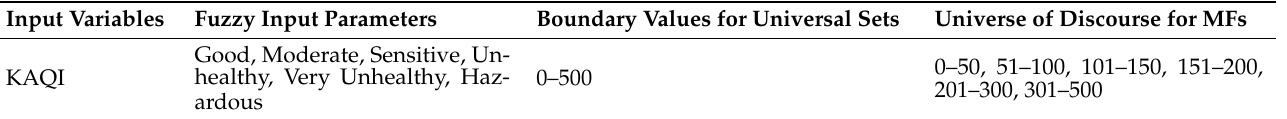
Table 3. The boundary values of crisp sets and fuzzy sets for output parameters, domain ranges, universe of discourse membership